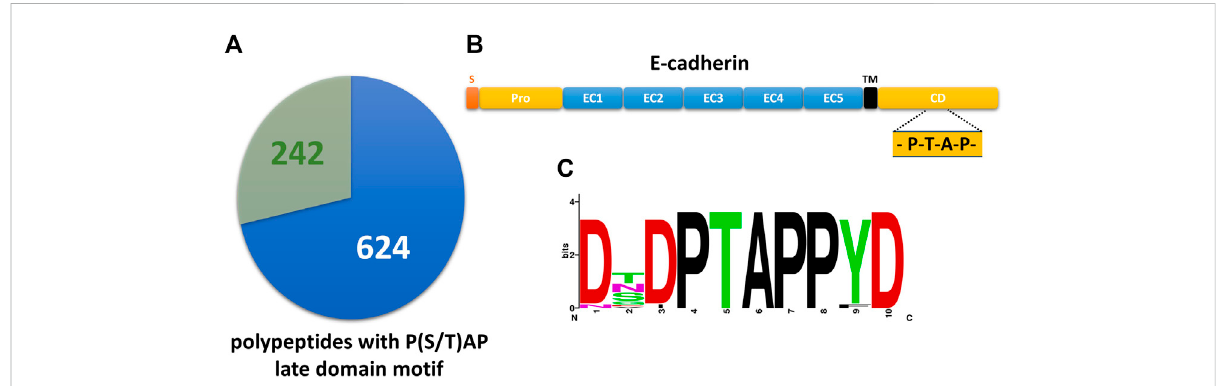
FIGURE 1 The cytoplasmic tail of E-cadherin comprises a highly conserved PTAP-late domain motif. (A) Pie chart showing 242 primary polypeptide sequencesoftheUniProtKB/Swiss-ProtdatabasethatcontainaP(S/T)APlatedomainmotifandarelistedinExoCarta(seealsoSupplementaryTable). 624 late domain containing sequences from the UniProtKB/Swiss-Prot database are not listed in ExoCarta. (B) Domain structure of E-cadherin. S,